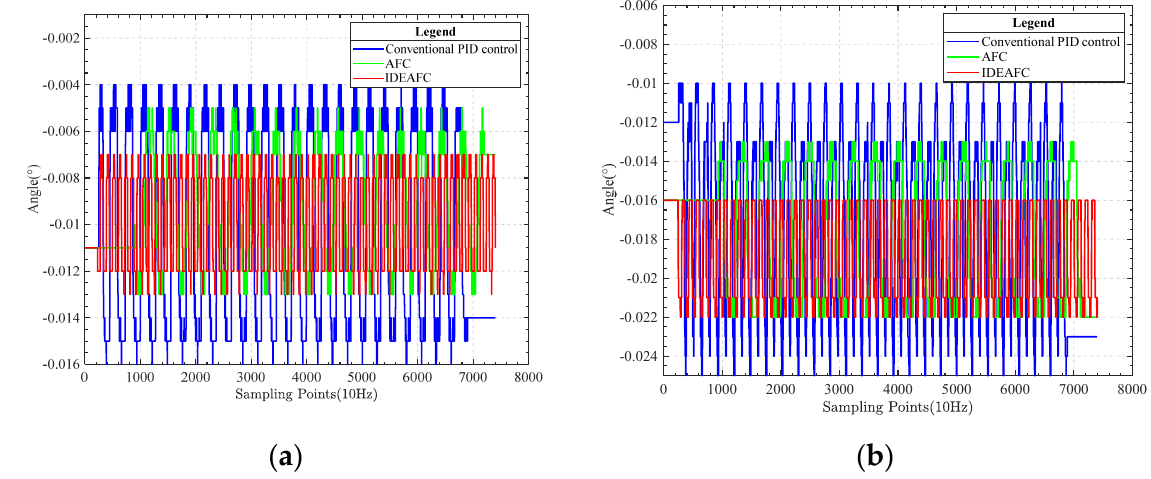
Figure 15. ( a ) Pitch angle data comparison; ( b ) roll angle data comparison.